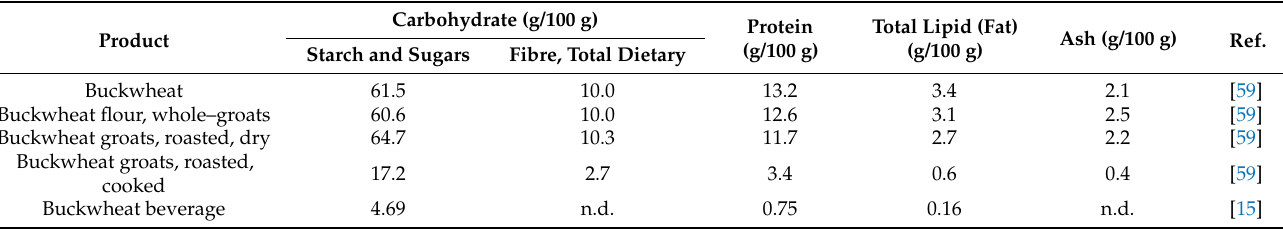
Table 5. Basic ingredients of buckwheat product per 100